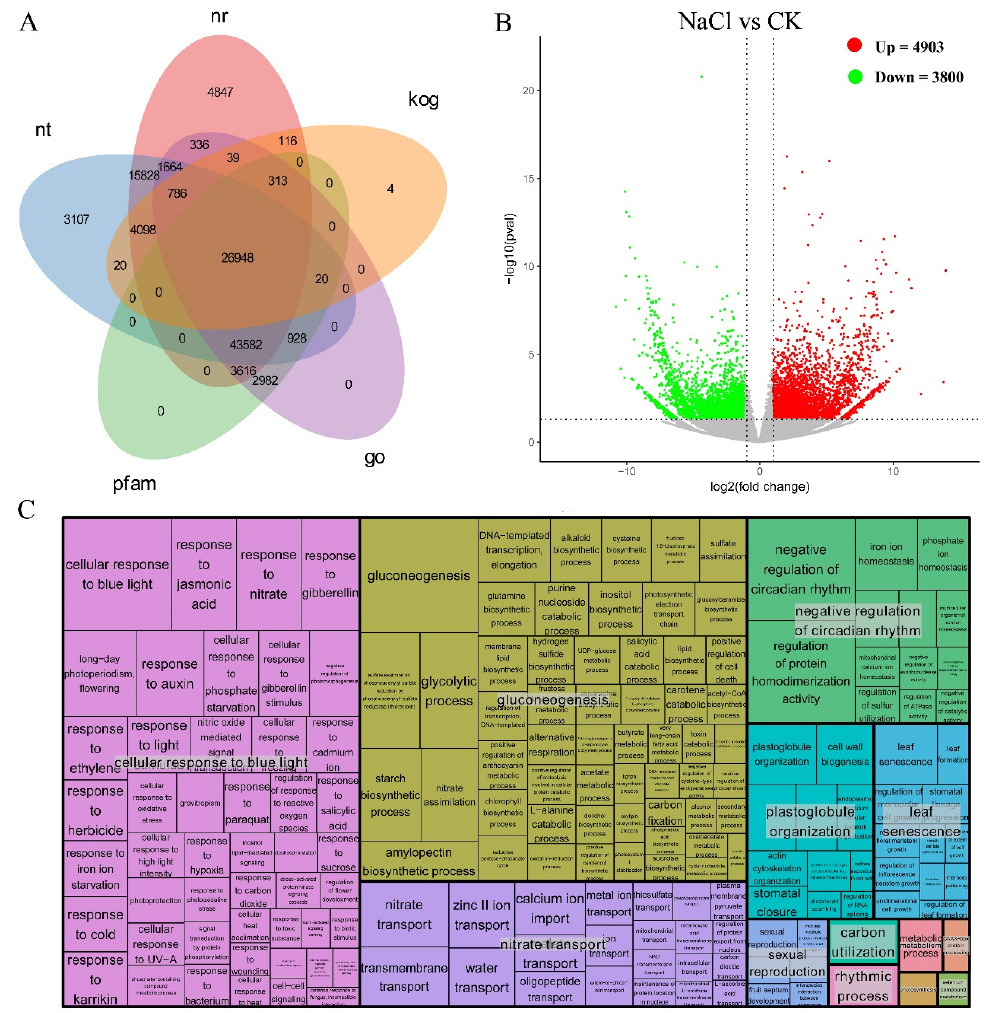
Figure 3. ( A ) Venn diagram of functional annotations of unigenes in Nt (NCBI non-redundant protein sequences), Nr (NCBI non-redundant protein sequences), KOG (Clusters of Orthologous Groups of proteins), GO (Gene Ontology) and Pfam (Proteinfamily) databases. ( B ) Volcano figure of up-regulated and down-regulated unigenes in Z. macrostachya . ( C ) REVIGO analysis of up-regulated di ff erently expressed genes (DEGs) in Z. macrostachya . Each rectangle is a single cluster representative. The representatives are joined into “superclusters” of loosely related terms, visualized with di ff erent colors. Size of the rectangles was adjusted to reflect the p value of the GO term calculated by TopGO.